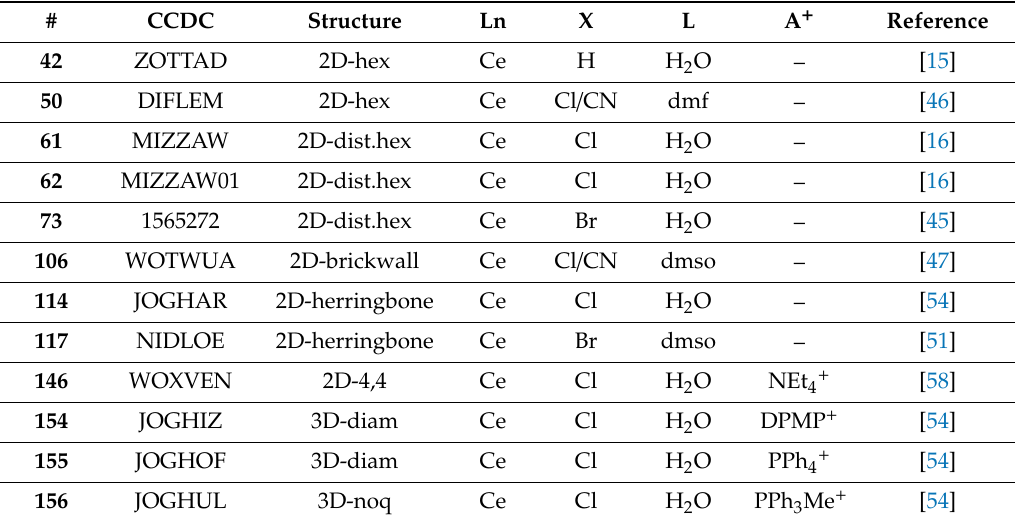
Table 15. Structurally characterized Ce(III) compounds with anilato ligands.